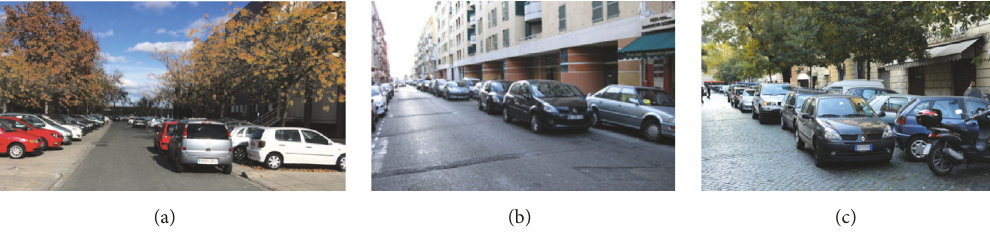
Figure 1: Double parking in Seville (a), Nice (b), and Rome